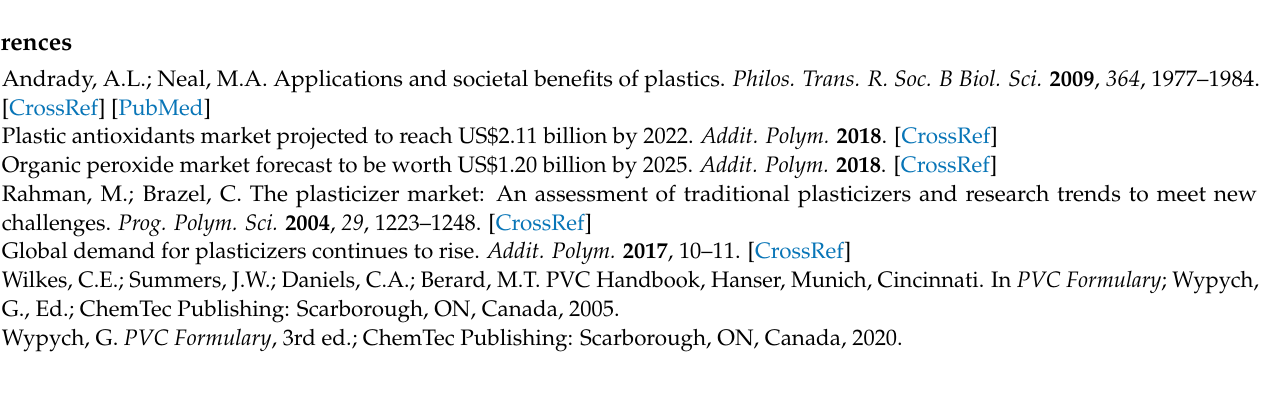
Figure S3: 40 MHz 1 H NMR spectra of all investigated plasticizers in non-deuterated n-hexane at a concentration of 1 vol. %. All spectra have been referenced to the signal of the n-hexane (0.8 ppm) peak. Figure S4: 1 H-NMR (a) T 1 and (b) T 2 relaxation times of TOTM and DIBP at all investigated concentrations measured at 40 MHz. For each concentration, the reported relaxation times are the average of three measurements. Figure S5: 13 C spectra of DIBP at various concentrations recorded at 40 MHz. The asterisks correspond to the signals from n-hexane. Figure S6: 1 H NMR spectra of a 0.05 mg mL − 1 DIBP solution in non-deuterated n-hexane in a stacked plot. SNRs at 3.5 ppm